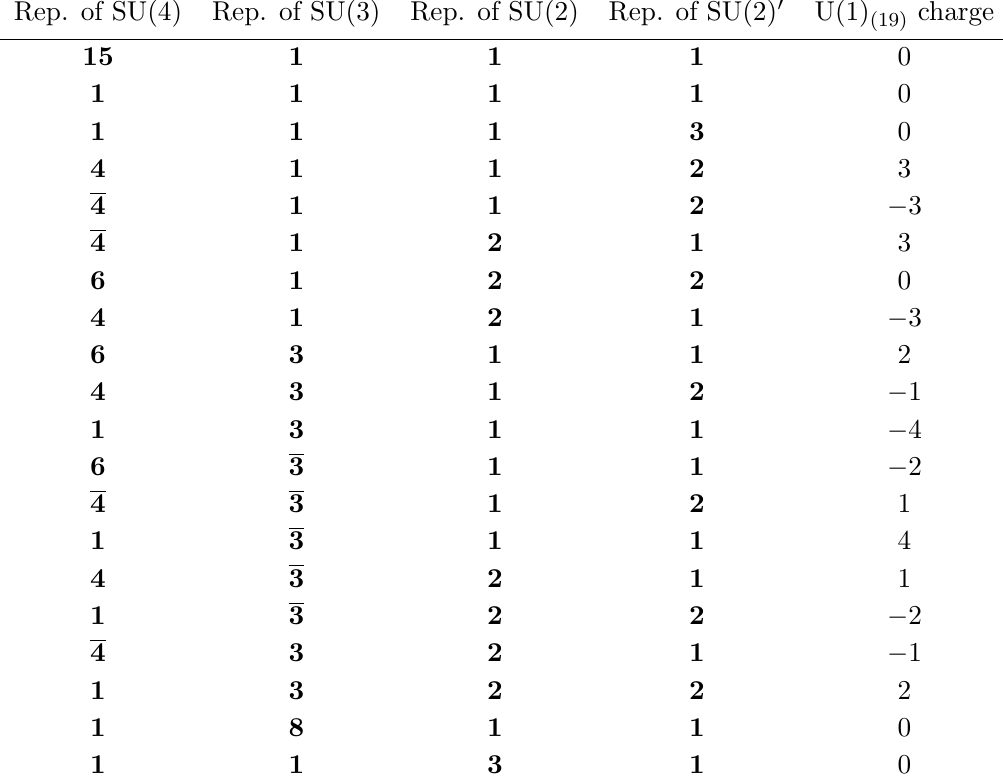
Table 13 . Decomposition of 248 in reps. of SU(4) (cid:2) SU(3) (cid:2) SU(2) (cid:2) SU(2) 0 (cid:2) U(1).